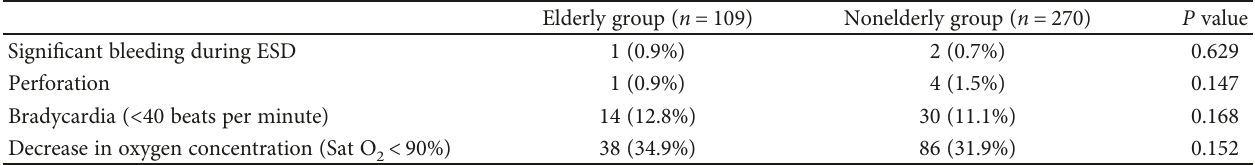
Table 2: The complications observed during ESD procedure.